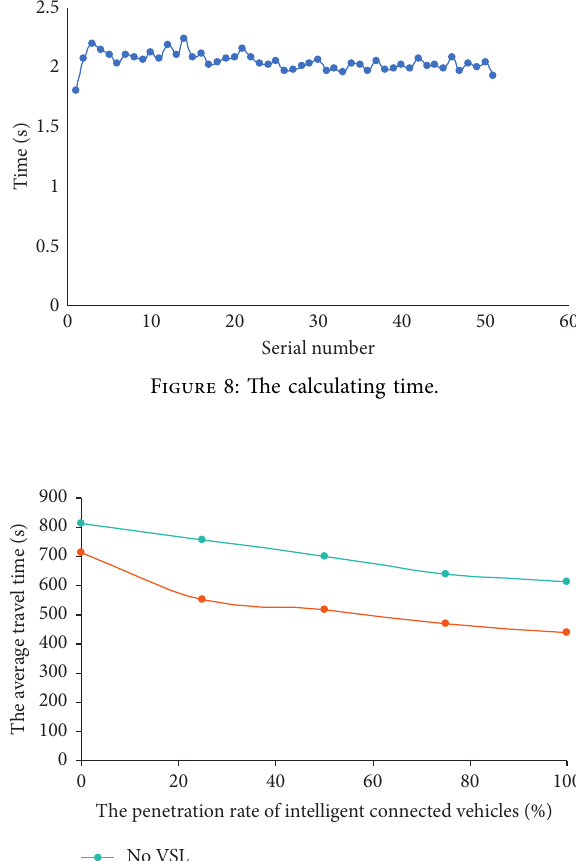
Figure 9: The average travel time result.